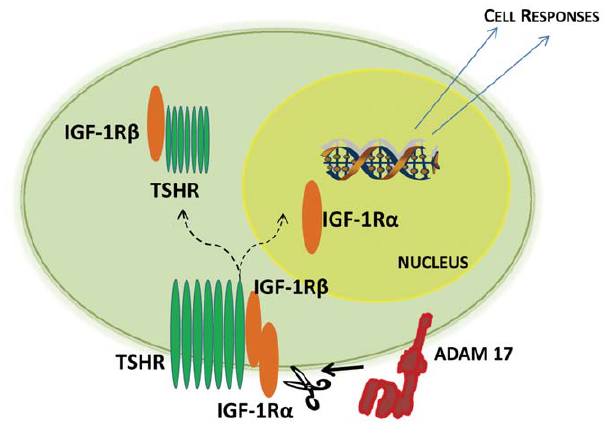
Figure 7. Schematic representation of the proposed transloca- tion of IGF-1R. ADAM 17 acts to shed IGF-1R into fragments. IGF-1R b complexes with TSHR. IGF-1R a translocates to the cell nucleus where it accumulates adjacent to chromatin. We hypothesize that it acts as a transcription factor, accounting for some of the cell responses peculiar to fibroblasts from patients with